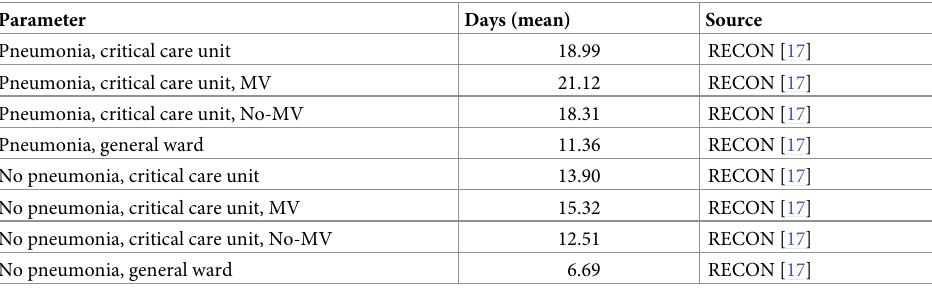
Table 3. Length of Stay (LoS).